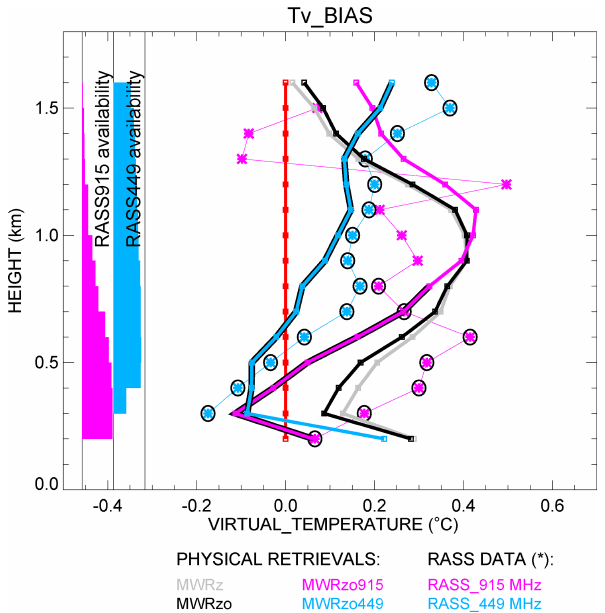
Figure 9. Bias of virtual temperature for all PR configurations com- pared to the original radiosonde measurements. A zero bias is de- noted by the red line. RASS data biases are marked by asterisks and by additional circles for the RASS data with more than 50% avail- ability, according to the availability bar charts on the left. All PR profiles are derived after applying the radiosonde BC method.